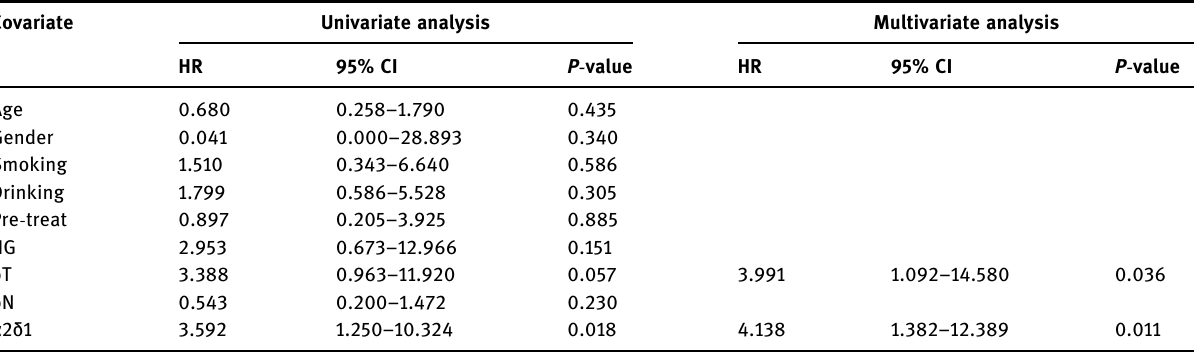
Table 3: Univariate and multivariate analysis of PFS in HSCC ( Cox regression )